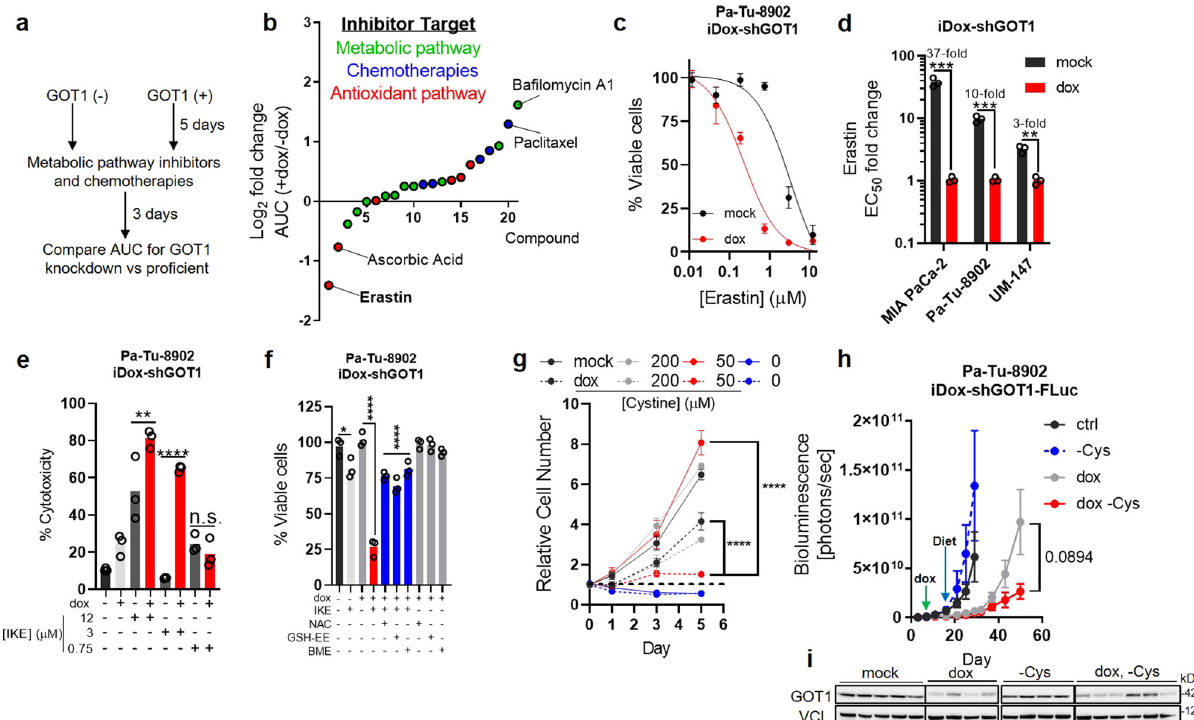
Fig. 2 PDA requires cystine for viability and growth following GOT1 inhibition. a Screening strategy to identify metabolic dependencies following GOT1 suppression. b Log 2 fold change in area under the curve (AUC) from cell viability dose response curves corresponding to each point, n = 3 biological replicates. c Cell viability dose response to erastin comparing mock (black) and GOT1 knockdown (red). d GOT1 sensitization represented as the